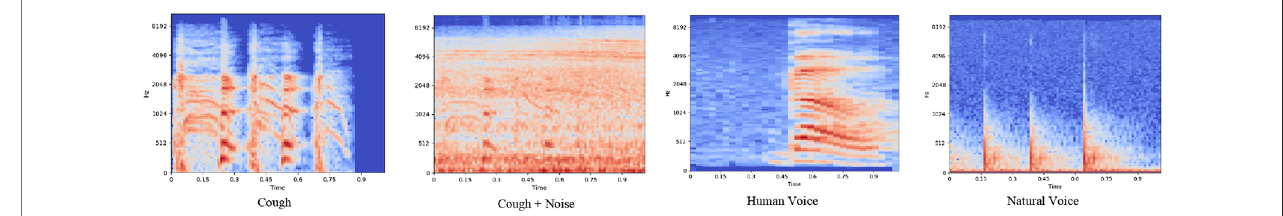
FIGURE 2 | Mel-spectrograms of different